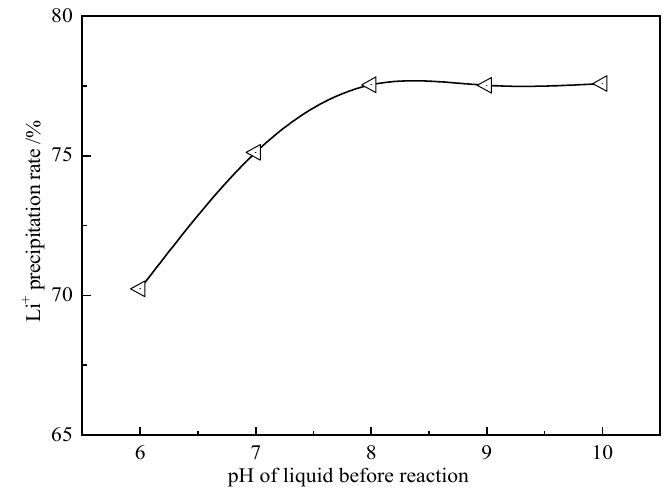
Figure 8. The relationship between pH value and Li + recovery.